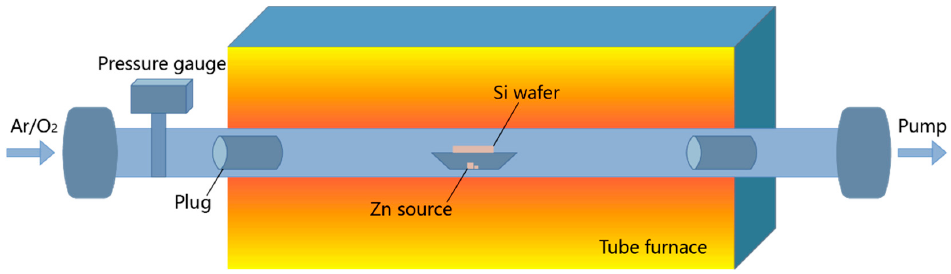
Figure 1. Schematic of CVD system used for the growth of ZnO NWs